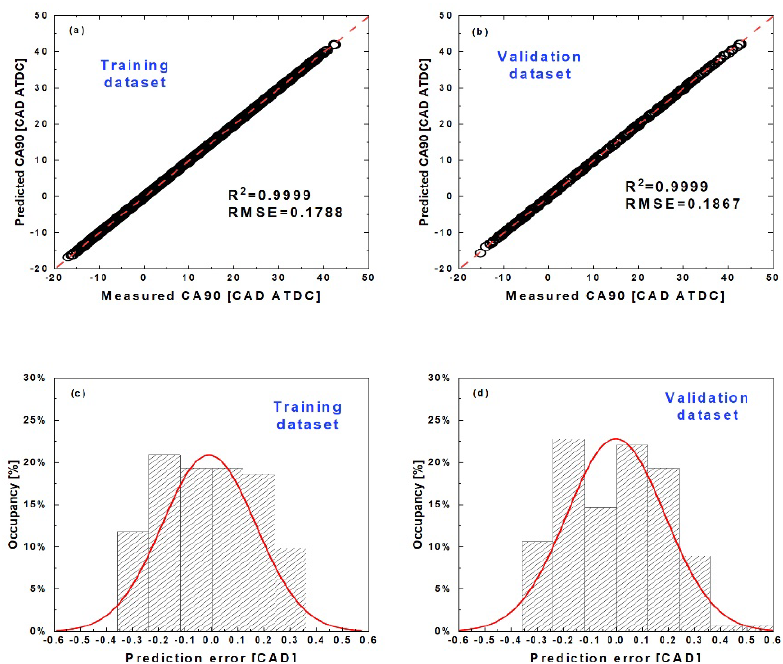
Figure 9. Comparison of predicted CA90 with the measured data. ( a ) Prediction performance of training dataset; ( b ) prediction performance of validation dataset; ( c ) prediction error of training dataset; and ( d ) prediction error of validation.